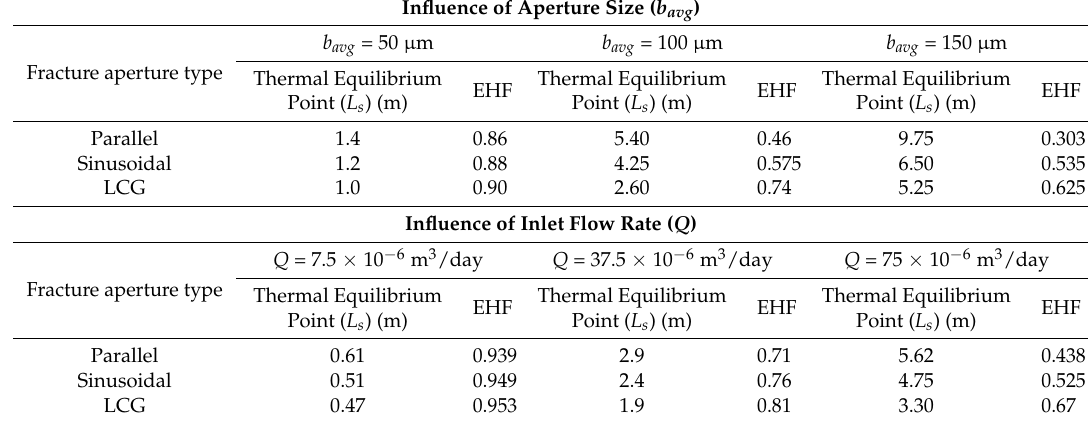
Table 3. L s (distance from the fracture inlet at which the temperature of the circulating fluid reaches that of hot rock) and effective heat transfer factor (EHF) values for different fracture aperture sizes and fluid flow